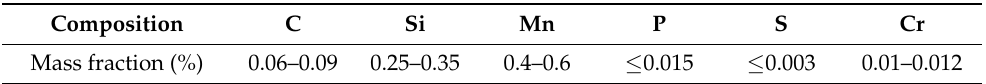
Table 15. Chemical composition of BX245-1Cr steel.